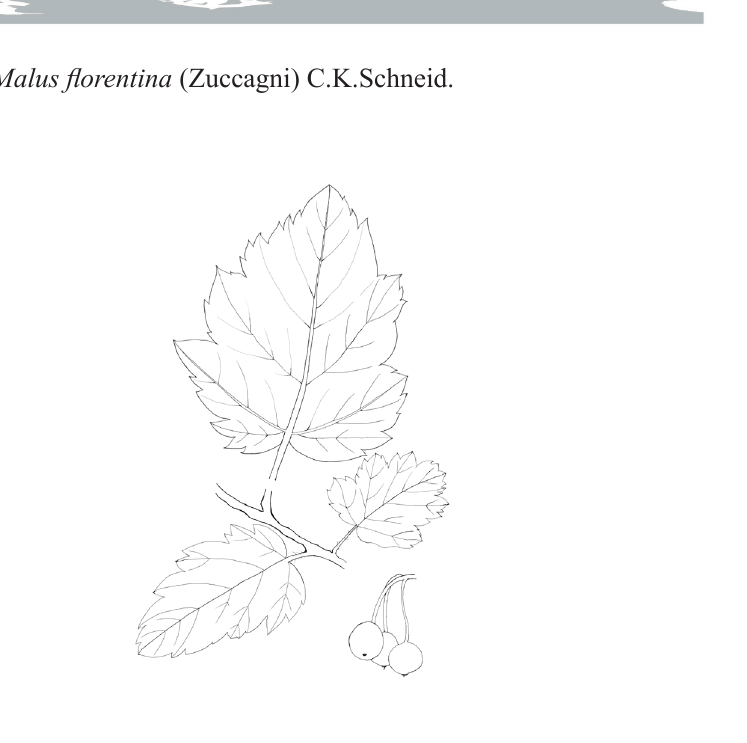
Fig. 54. Morphological characters of Malus florentina (Zuccagni) C.K.Schneid. Drawn by J.C.